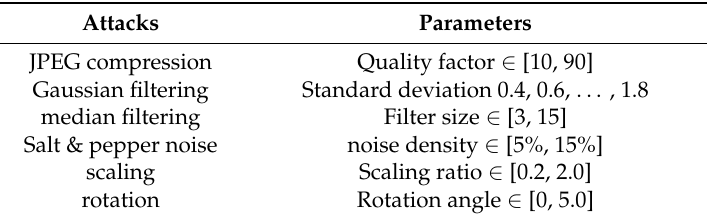
Table 2. The content-preserving attacks for robustness